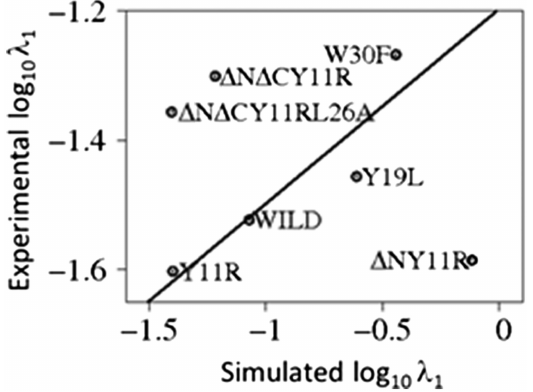
Figure 3. A correlation plot of the experimental and simulated fast cumulative constants with a least-squares fitting line. The experimental rate constants are expressed in µ s − 1 , while those obtained from simulations are expressed in ns − 1 . Reproduced from R. Zhou et al. Proc. Natl. Acad. Sci. USA , 111, 18243–18248 (2014). Copyright 2014 National Academy of